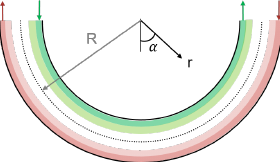
Figure 12: Stress distribution in a corrugated laminate half-cell sub- jected to torsional loading. The plot shows the relevant parameters known in planar